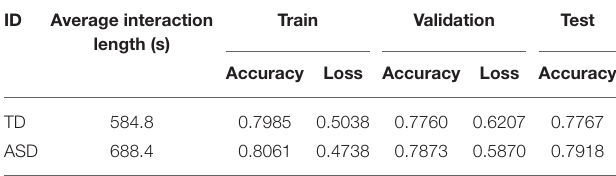
TABLE 4 | Average metrics to compare classifier performance. TABLE 5 | Performance metrics for group